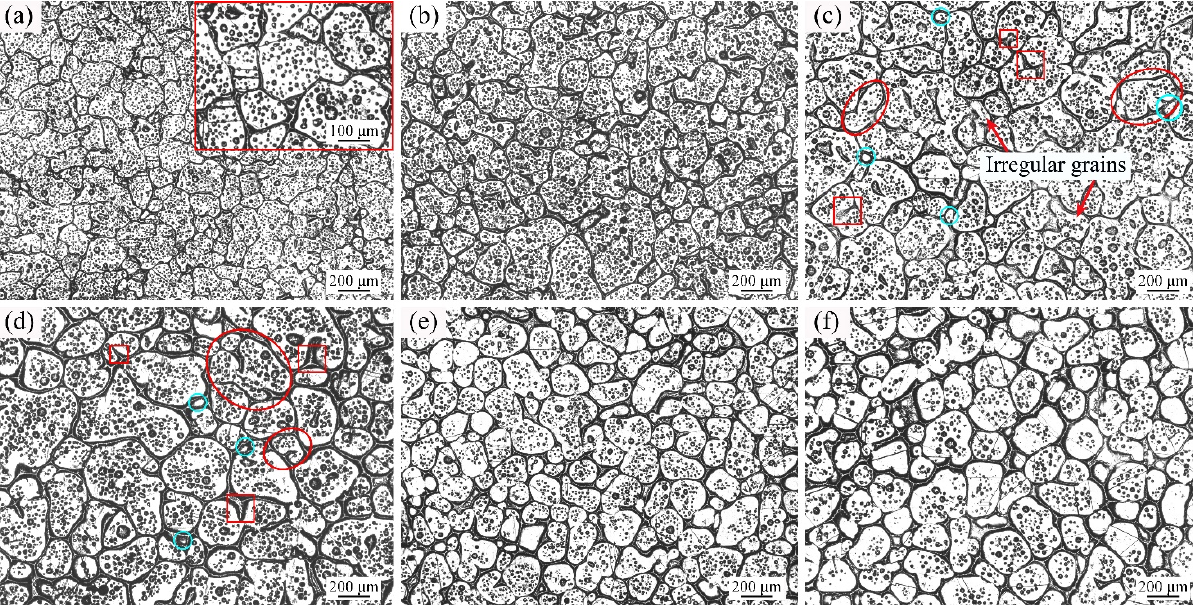
Figure 4. Optical micrographs of GH3536 alloy heat treated at 1360 °C for ( a ) 5 min, ( b ) 15 min, ( c ) 30 min, ( d ) 60 min, ( e ) 90 min, and ( f ) 120 min.